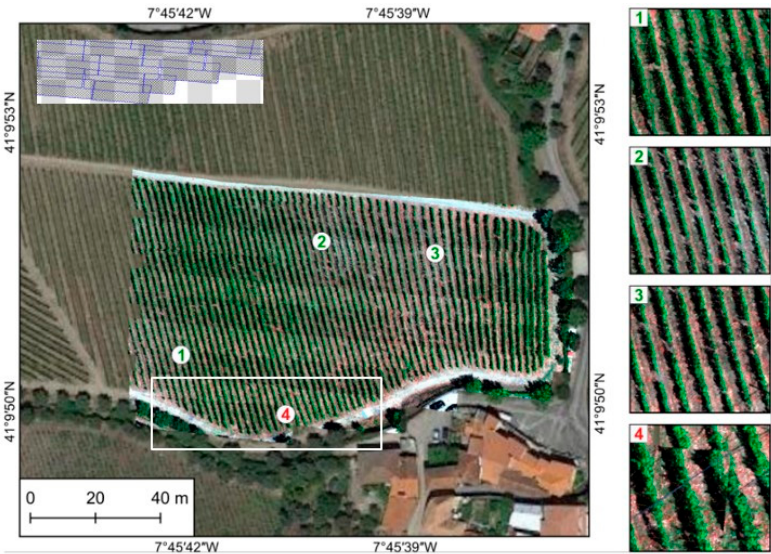
Figure 18. Vallado area: overview of the final hyperspectral mosaic and close-ups to show the good alignment achieved by continuous linear features ( 1 – 3 ). Few misalignments are still present, but only at the edge of the mosaic ( 4 ). In the upper left corner, hyperspectral frames coverage from the white rectangle. Incomplete frames make its adjustment more complex, as in ( 4 ).